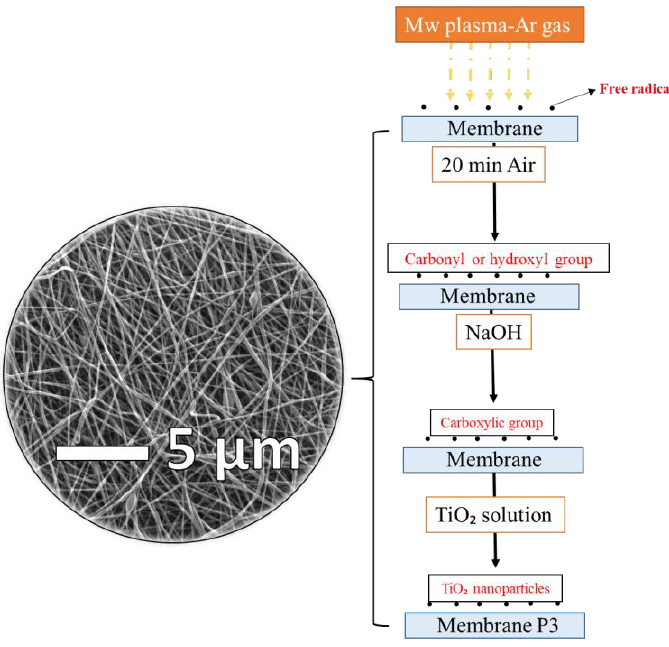
Figure 8. Schematic diagram of the surface modification of PVDF/PAN membranes.